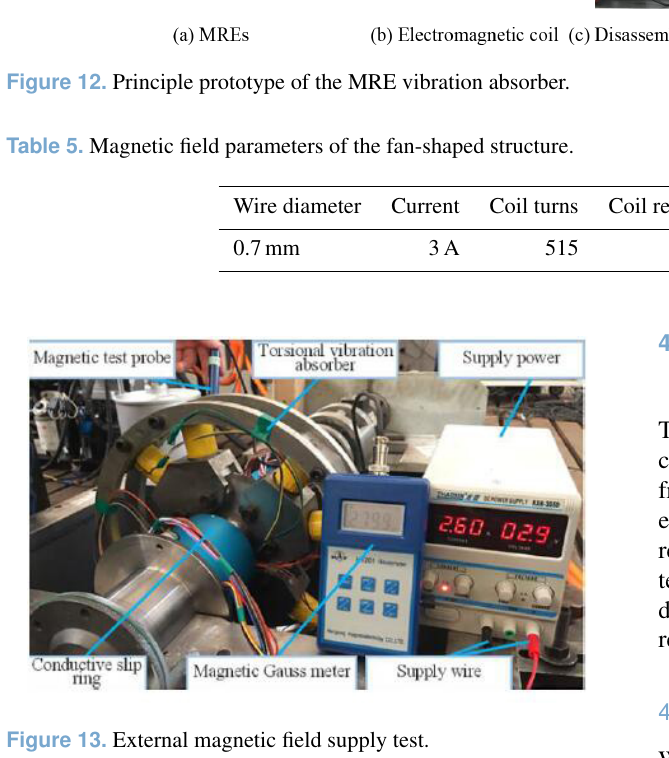
Figure 13. External magnetic field supply